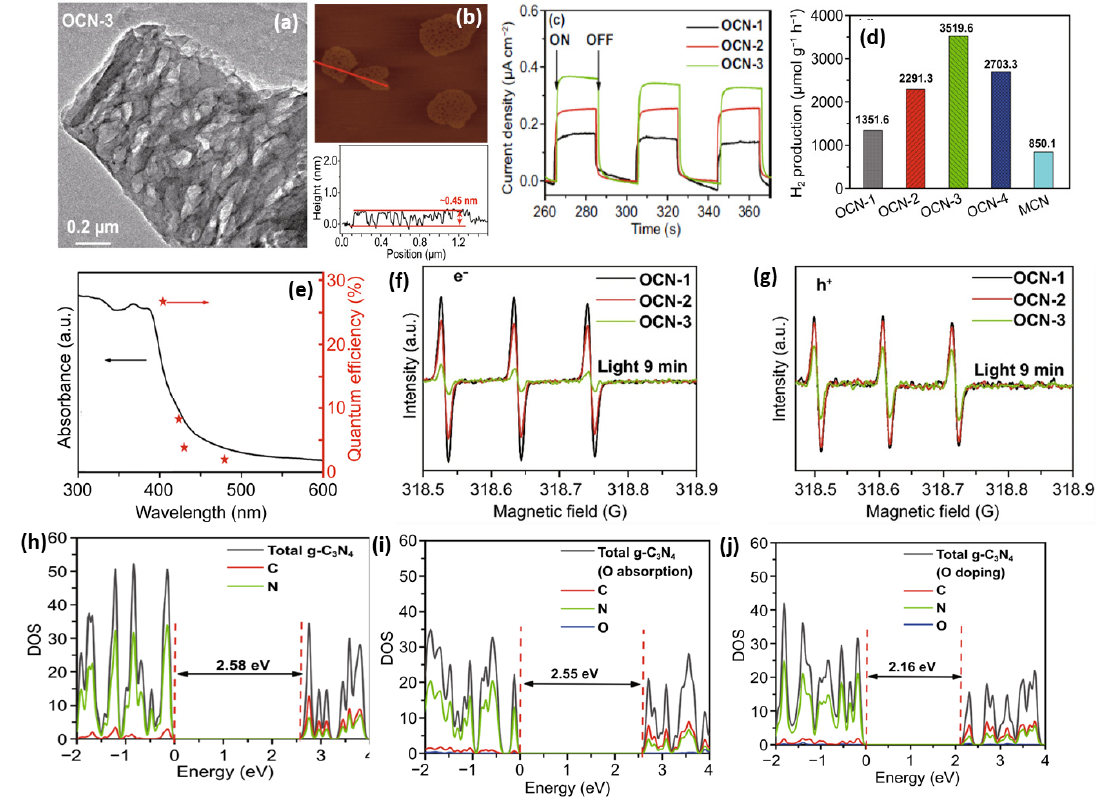
Figure 9. ( a ) TEM, ( b ) AFM image of OCN-3. ( c ) Transient photocurrent responses and ( d ) H 2 production rate under optical filter ( λ > 420 nm) of OCN-1, OCN-2, and OCN-3. ( e ) The QE–wavelength curve of OCN-3. ( f ) ESR of electron and ( g ) hole on OCN-1, OCN-2, and OCN-3. The density of state of ( h ) bare g-C 3 N 4 , ( i ) O-doped g-C 3 N 4 , and ( j ) O-CN. Adapted with permission from Ref. [132]. 2022, Elsevier